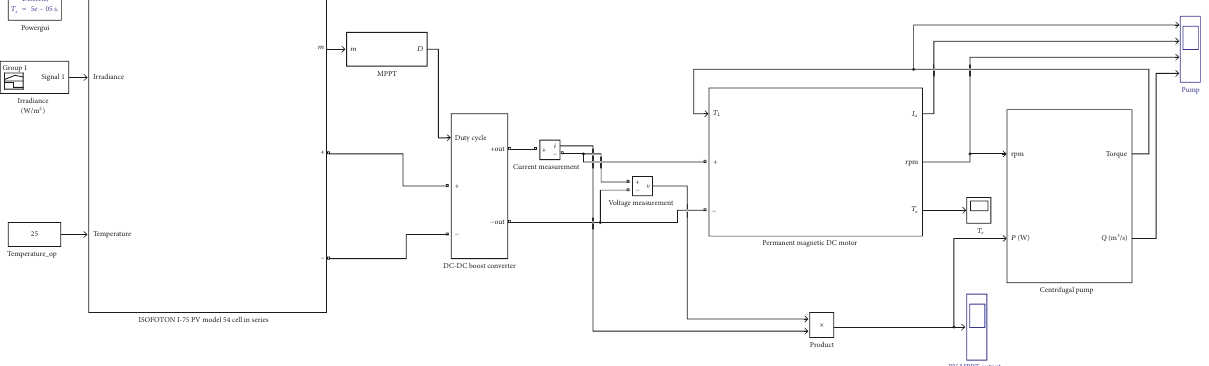
Figure 15: Directly coupled solar water pumping system model.